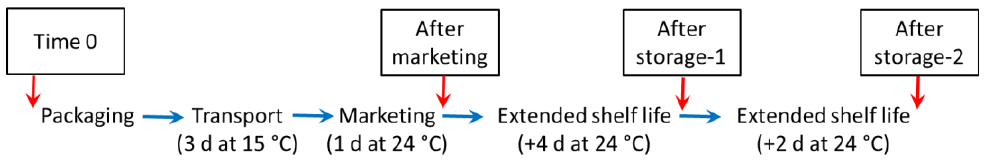
Figure 1. Schematic illustration of the transport, marketing, and storage of bananas. Red arrows indicate the time points for quality evaluations.